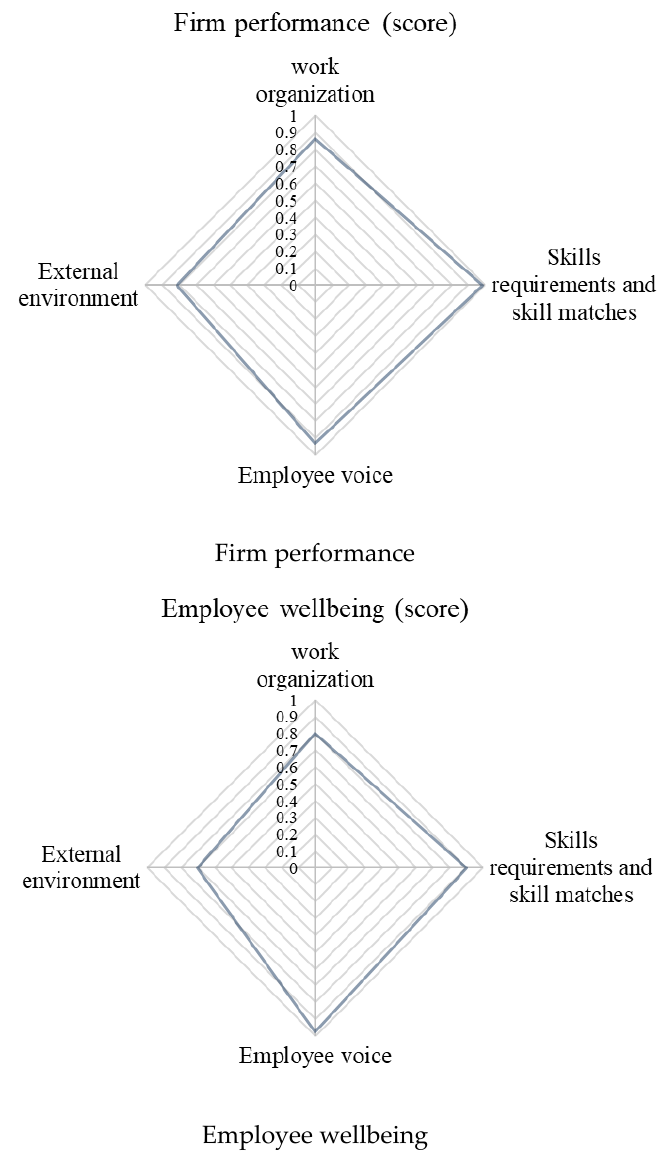
Figure 12. Analyzing the effects of independent parameters on output values.